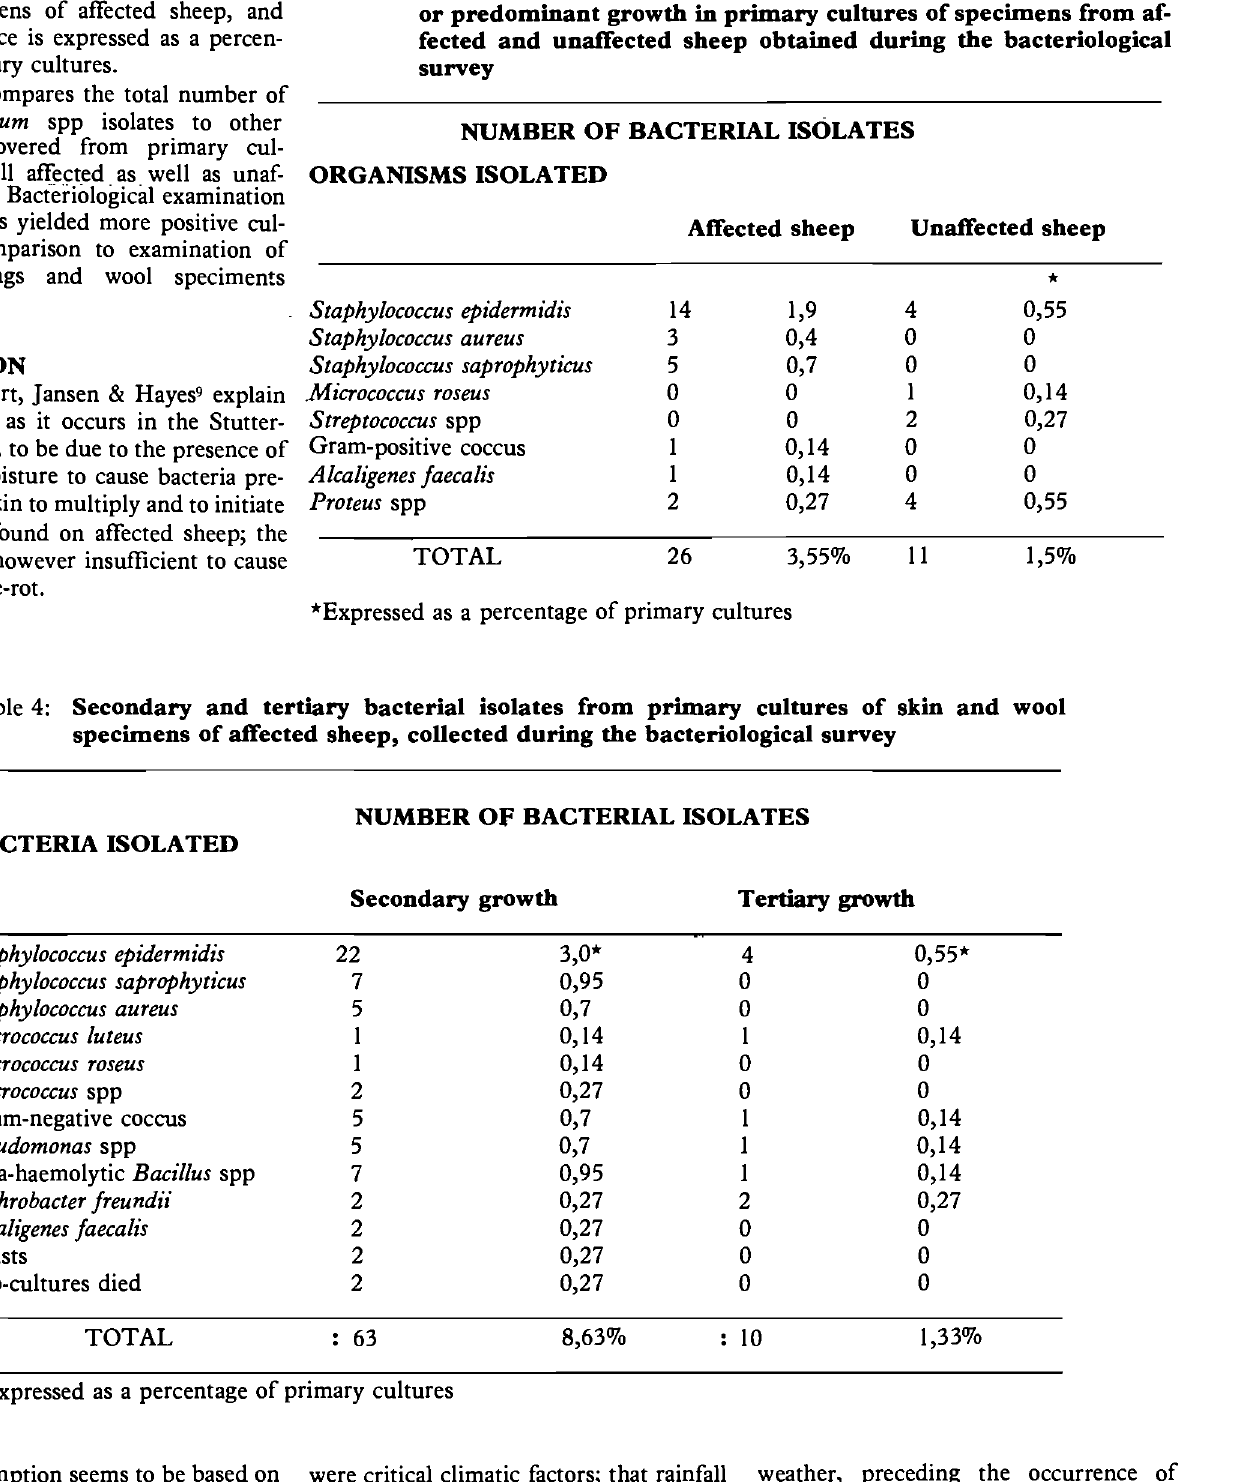
Table 3: Bacteria other than Corynebacterium spp which occurred in pure